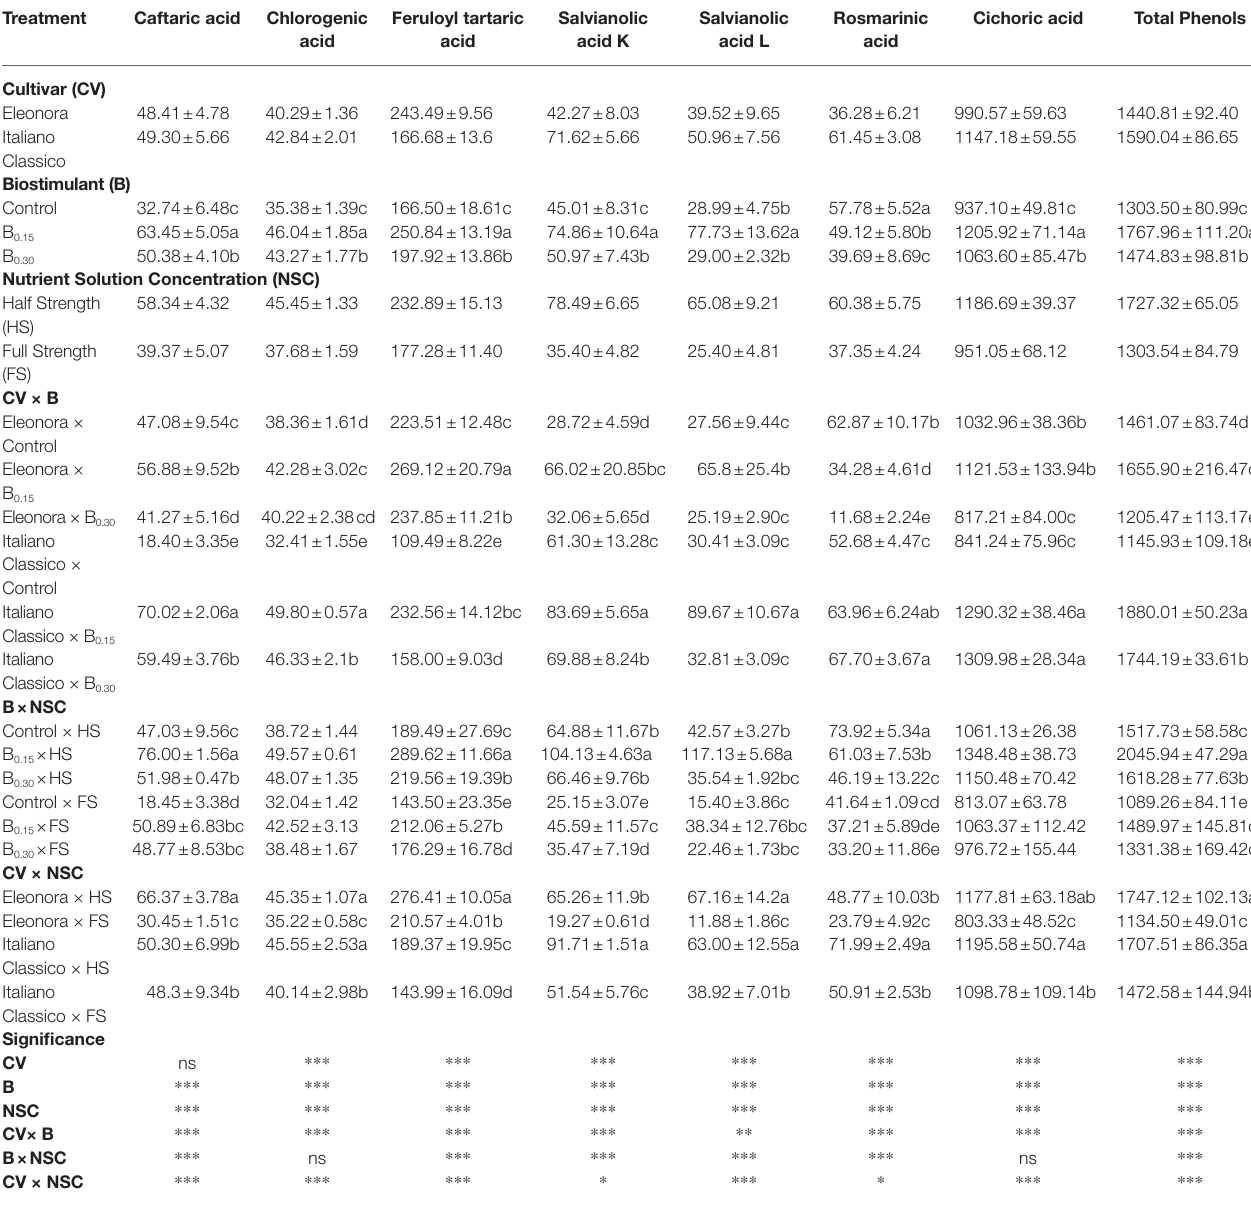
TABLE 3 | Analysis of variance and mean comparisons for phenolic acids in Eleonora and Italiano Classico genotypes grown hydroponically under two nutrient solution and dose of biostimulant.